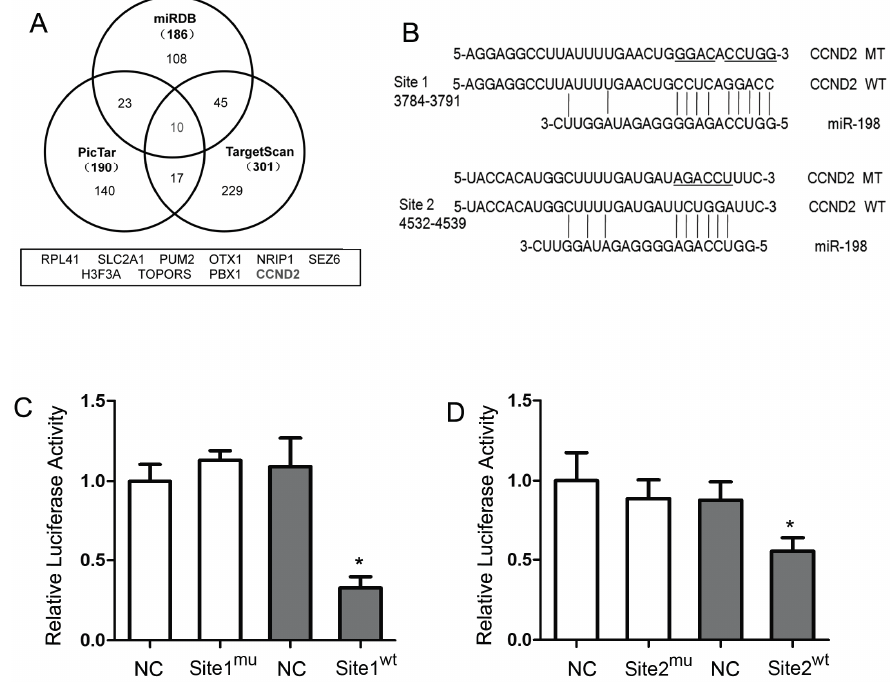
Figure 2. MiR-198 directly bound to the 3 ′ -UTR of CCND2 mRNA. ( A ) Bioinformatics analyses showed that 10 potential target genes of miR-198 were predicted by three different databases; ( B ) The two distinct predicted binding sites of miR-198 in the 3 ′ -UTR of CCND2 mRNA were allocated, and the fragments containing either mutated binding site were amplified according to the mature miR-198 sequence; ( C ) In pMIR-REPORT™ vector, CCND2 mRNA 3 ′ -UTRfragment containing either the wild type or the mutated Site 1 was fused downstream the reporter gene. When the vectors were cotransfected with miR-198 mimic or mimic control, and the relative luciferase activity, normalised by β -gal, was significantly suppressed in vector with wild type Site 1 than that with mutated Site 1 (32.80% ± 6.89%); ( D ) In the presence of wild type Site 2, not the mutated one, miR-198 was able to significantly inhibit luciferase activity although to a less extent than wild type Site 1 (55.39% ± 8.48%). (NC, negative control; WT, wide-type; MT, mutated-type. * Compared with NC, p <